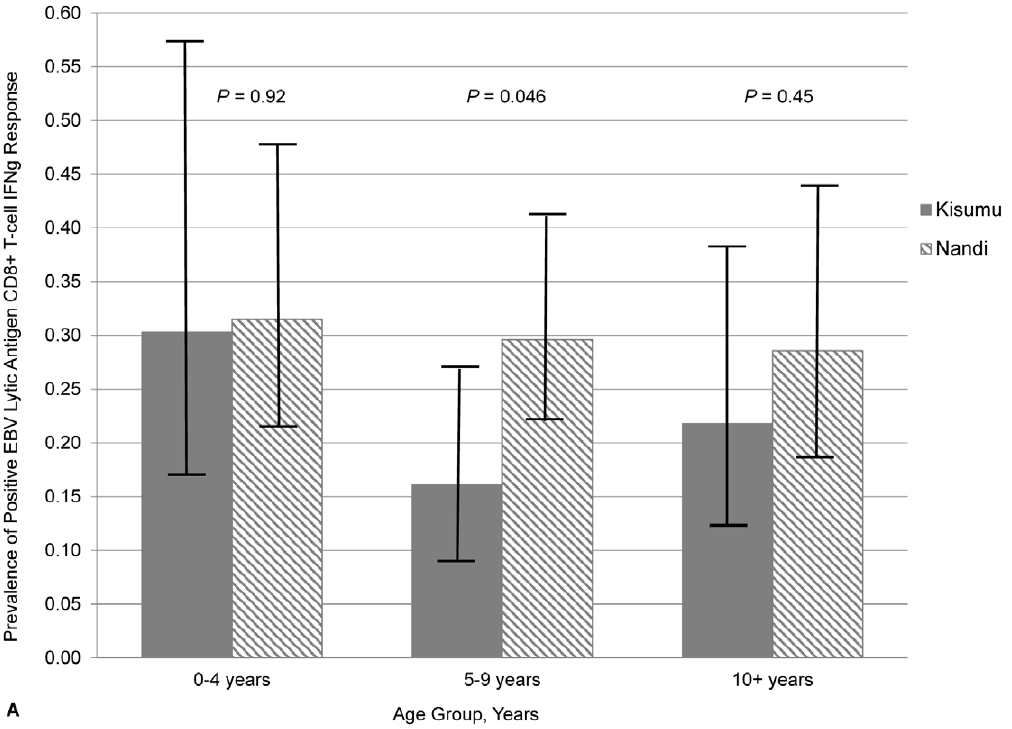
Figure 3. Prevalence of EBV-specific CD8 + T-cell IFN c response by age group and residence. Prevalence of positive EBV lytic (A) and latent (B) antigen CD8 + T-cell IFN c response by age group and site of residence, Kenya 2002–2004. Age group was classified as a time-varying factor. For both graphs, the number of observations for children in each age group in Kisumu was: 33 (0–4 years), 87 (5–9 years) and 78 ( $ 10 years). The number of observations for children in each age group in Nandi was: 54 (0–4 years), 125 (5–9 years) and 70 ( $ 10 years). P values for differences between areas of residence by age group are indicated.